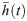
Realization-dependent oscillatory imprint on the self-tuned chaotic regime.(A) Sample traces h¯(t) (top), and normalized autocorrelation q¯(τ) (bottom) of coherent mode current for a connectivity realization with complex eigenvalue for J1 = 25,30,35 increasing from left to right. Dynamics exhibit pronounced oscillatory power and the autocorrelation exhibits a pronounced peak near the same frequency that will dominate the limit cycle for larger J1. (B) Height of second peak of the autocorrelation of the coherent mode input as a function of J1. Each colored line represents a single connectivity realization, averaged over 10 initial conditions. For many realizations, there is a significant second peak in the autocorrelation over a long range of values of J1 well before a limit cycle is reached. We display the 63 realizations which had complex leading eigenvalue out of 100 in this set of trials. Thick black line shows average over those realizations. (C) Observed period of oscillatory chaos vs phase of leading eigenvalue for 181 realizations from which we were able to measure an oscillatory period with chaotic fluctuations (out of 196 realizations with complex leading eigenvalue in this set of trials. In order to confine to realizations and values of J1 that yielded chaos, we restrict to those with second peak of autocorrelation less than 0.8. These had average height of second peak over all realizations: 0.5). Dotted line shows prediction from theory: 2πPhase(λ1). The bulk of realizations are very well predicted although a notable fraction are not. The median error of prediction was 7.75 (average period over these realizations: 231, std: 212). N = 8000 for all panels.